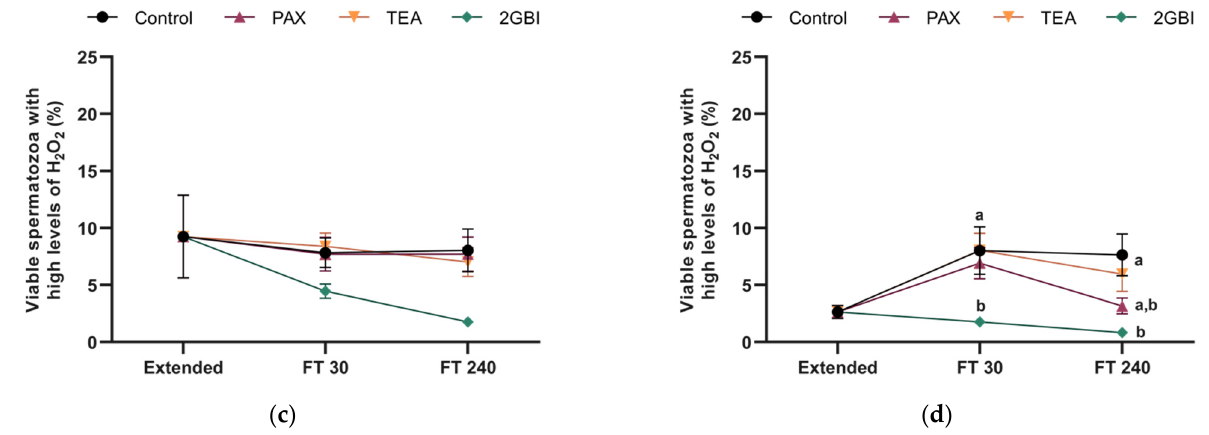
Figure 8. Mitochondrial superoxide levels expressed as percentages of viable spermatozoa Mito-E + /YO-PRO-1 − ( a , b ),